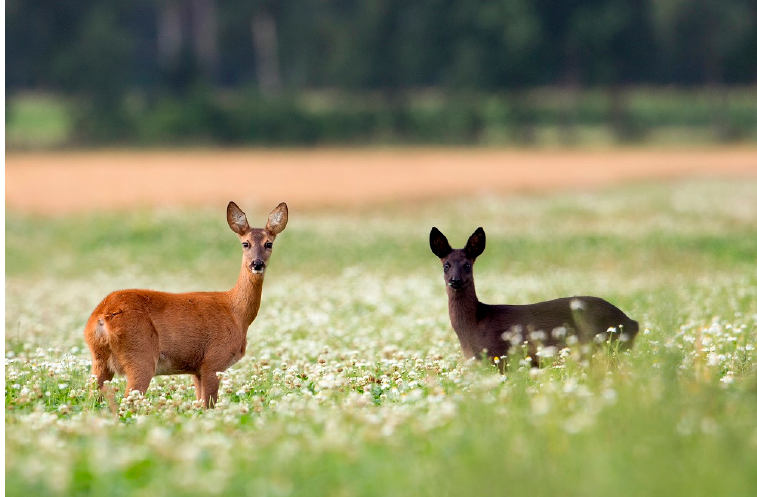
Figure 1. Chestnut and melanistic European roe deer (photo presented by Jan Piecha).